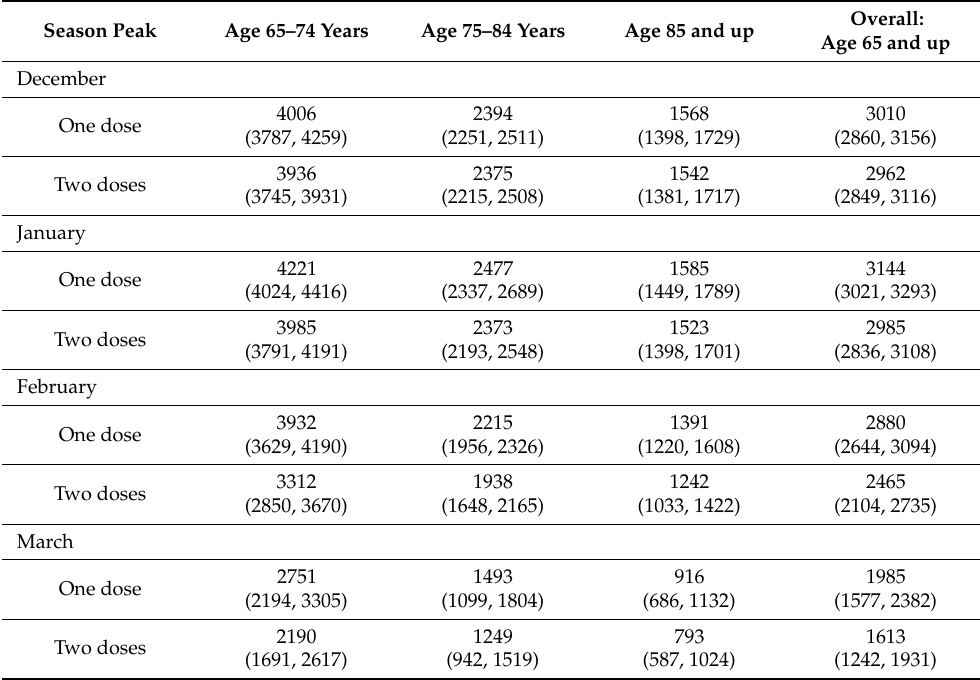
(Table 3), based on model parameters set to approximate a 9% overall hospitalization rate of symptomatic cases for age ≥ 65, with higher rates of hospitalizations in ages 75–85 and ≥ 85 and up. Table 2. Symptomatic influenza cases per 100,000 population by peak month and by age group in ages 65 and up *.